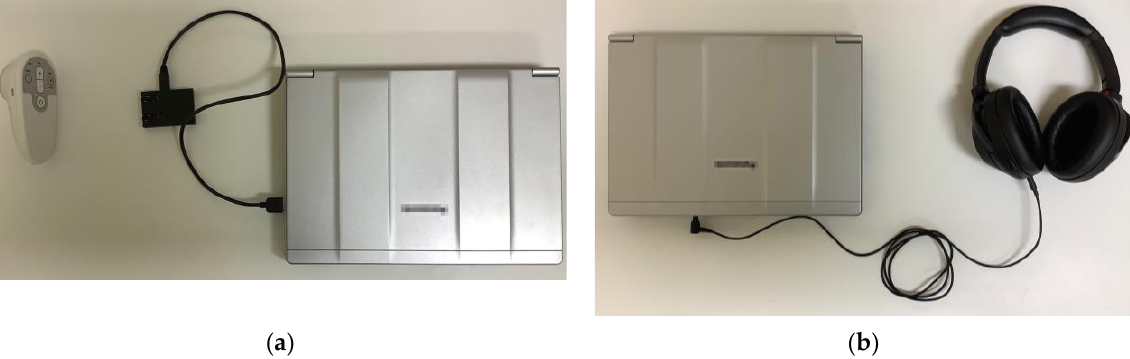
Figure 2. ( a ) Remote auscultation equipment at the researcher site and ( b ) the participant site, including an electronic stethoscope, a wireless module for the electronic stethoscope option, and a noise-canceling stereo headset.